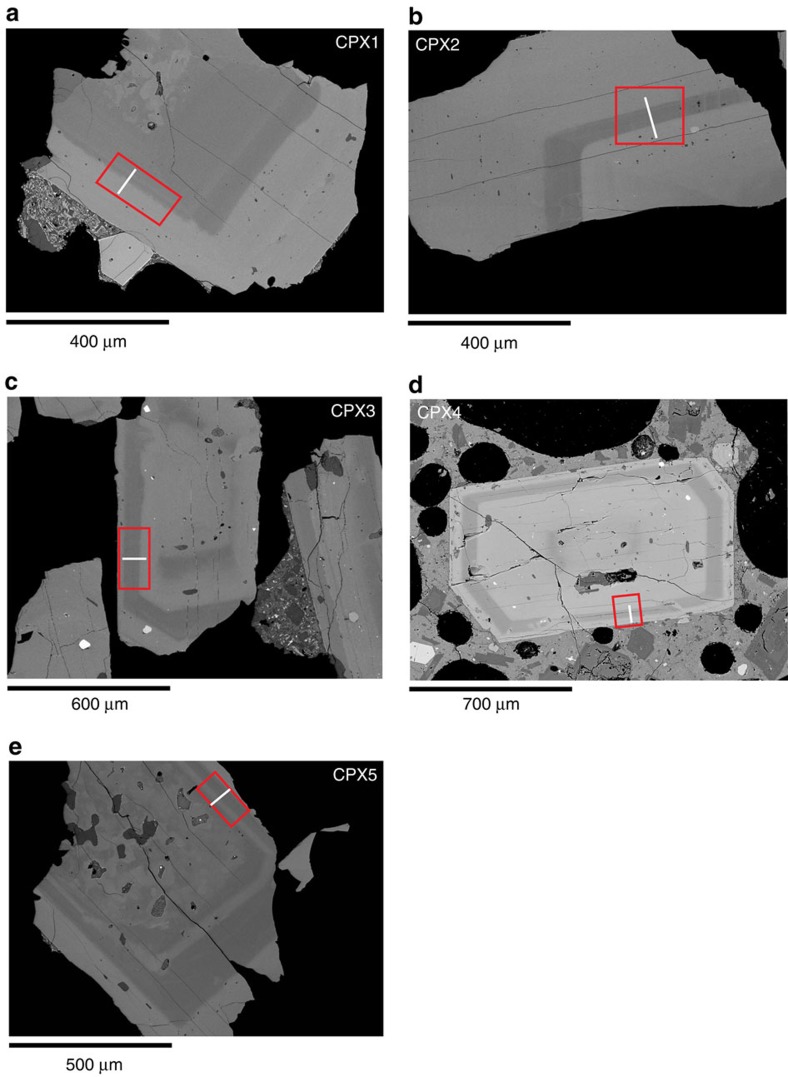
Zoned clinopyroxene.High-resolution back-scattered electron (BSE) images of selected clinopyroxene crystals of Stromboli volcano modelled in this study. The red boxes indicate the area where the grey scale raster has been determined using the ‘greyscale calculation’ described in Methods, whereas the white line is where the electron microprobe profile has been measured (Methods). (a) clinopyroxene 1 (CPX1); (b) clinopyroxene 2 (CPX2); (c) clinopyroxene 3 (CPX3); (d) clinopyroxene 4 (CPX4); (e) clinopyroxene 5 (CPX5).